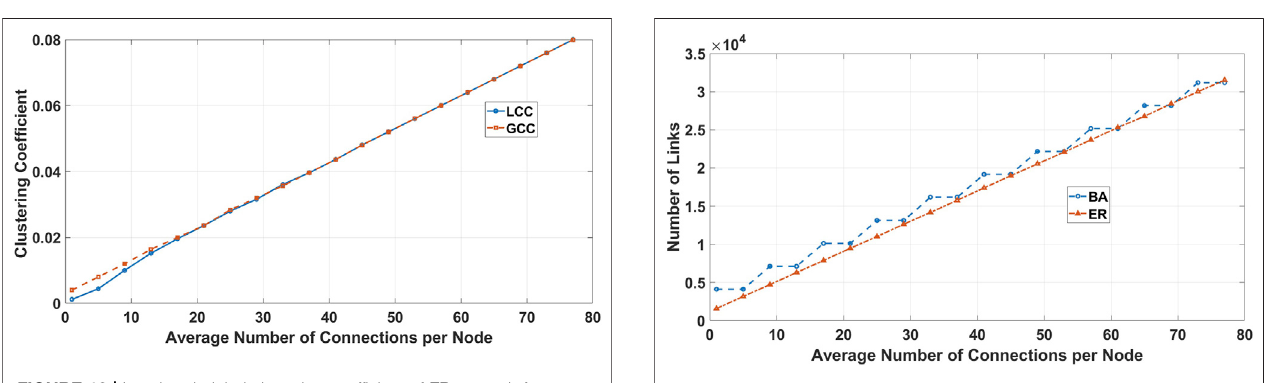
FIGURE 10 | Local and global clustering coef fi cient of ER network for N = 10 000